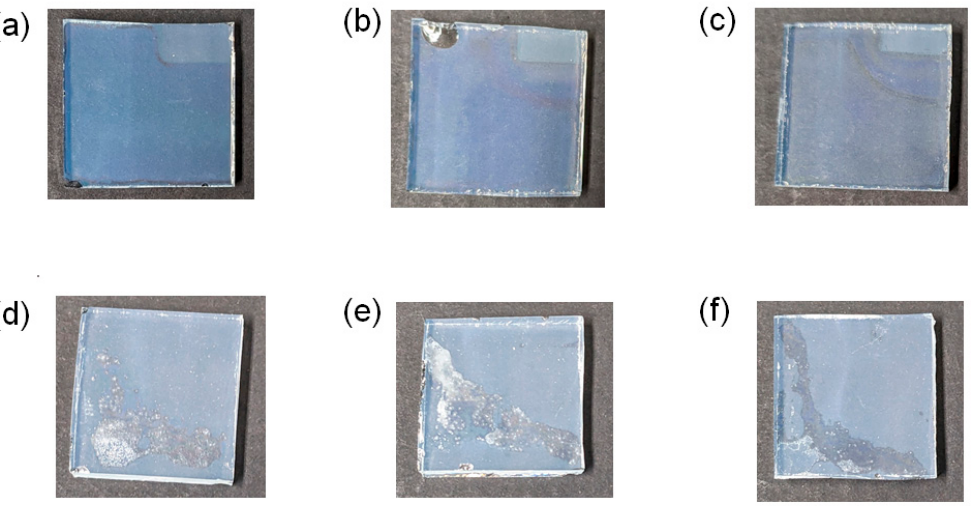
Figure 2. Photos of several Sn/Ti oxides-deposited FTO glass substrates after heat treatment at 500 ◦ C. Samples ( a – c ) were prepared by using a precursor solution of tin and titanium compounds dissolved in a mixed ethanol/terpineol base liquid. The ratios of tin and titanium ions (Sn/Ti) in the